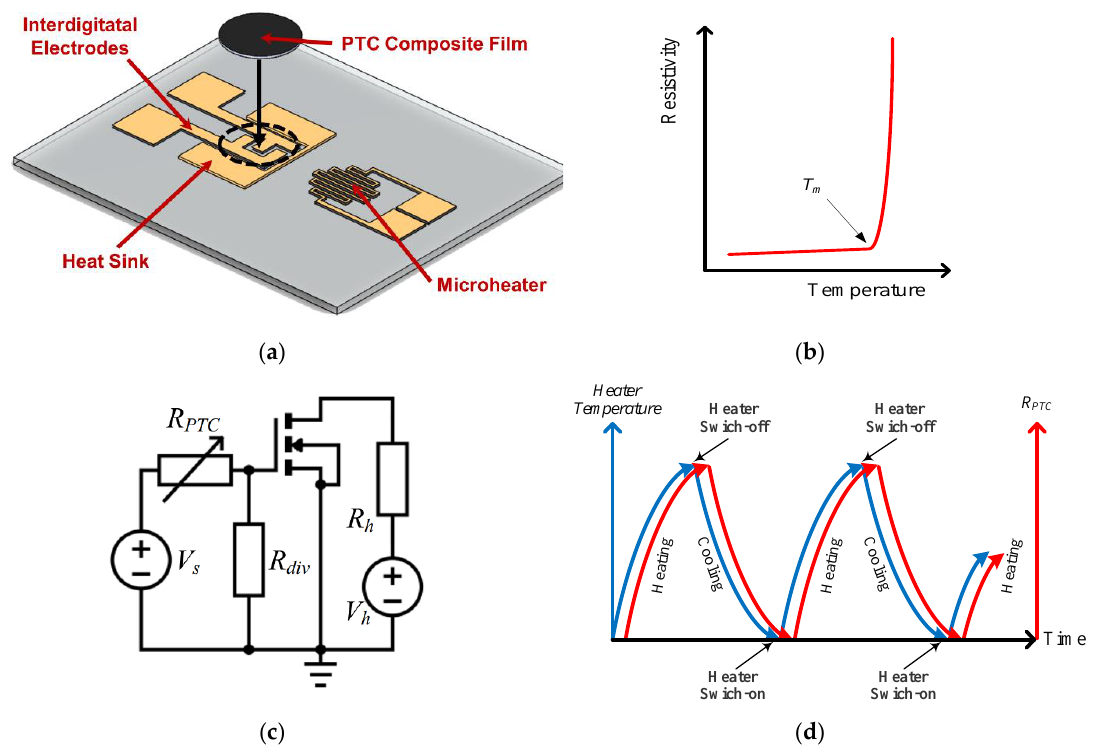
Figure 1. Illustration of the proposed DC-driven oscillator device. ( a ) Schematic of the thermal oscillator. ( b ) Resistivity–temperature characteristic of positive temperature coefficient (PTC) materials. ( c ) The circuit diagram. ( d ) Illustration of the self-switching on–off phenomenon.